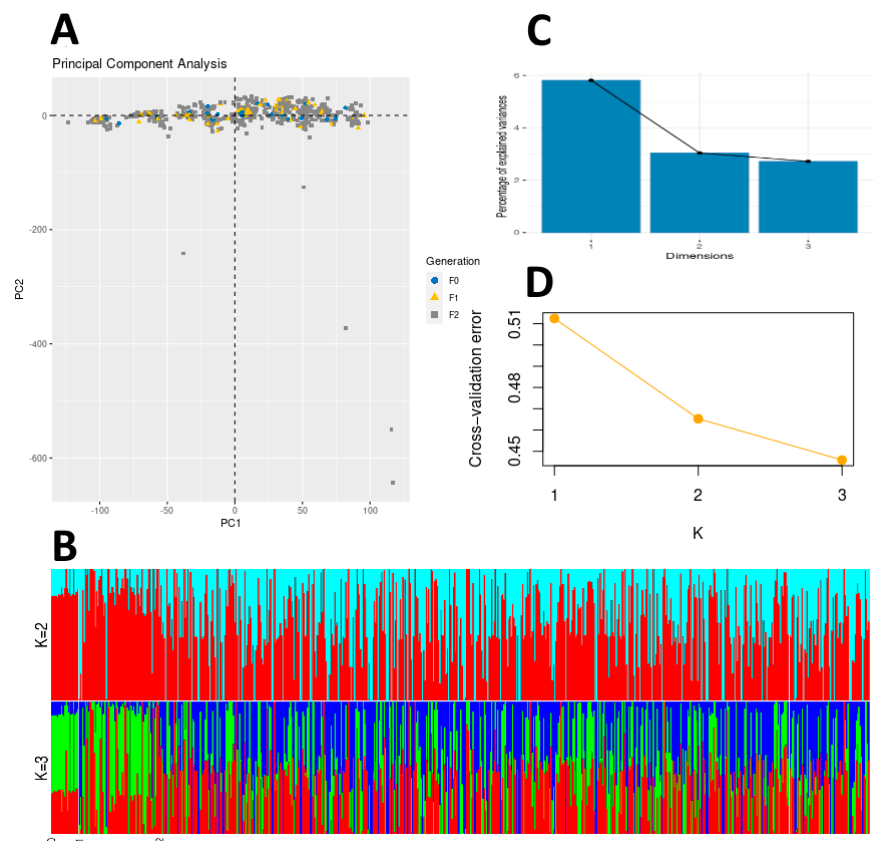
Figure 1. ( A ) PCA plot generated from Adegenet analysis. The principal components represent different sources of genetic variance, and points on the graph represent individuals, while colours and shapes of each point represent different generations. If distinct groups exist within the sampled individuals, then they will form different clusters. ( B ) Barplot of ADMIXTURE analysis results for K = 2 and K = 3. ADMIXTURE analysis calculates ancestry coefficients, which is the proportion of an individual genome that belongs to a certain ancestral population. The x-axis contains all individuals, grouped by generation from F 0 to F 2 . The y-axis shows, in different colours, the proportions of the individuals’ genome belonging to different ancestral populations. K is the number of ancestral populations used in the analysis. ( C ) Scree plot showing the percentage of variance explained by the first three principal components from Adegenet PCA. ( D ) Cross-validation error for different values of K generated by ADMIXTURE.